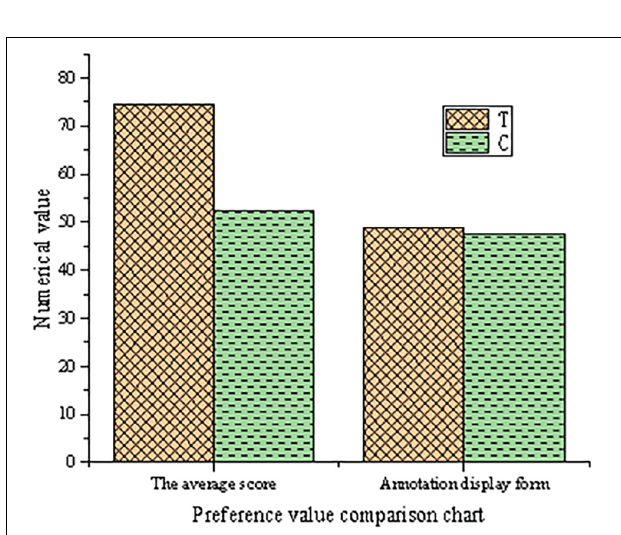
FIGURE 8 | Comparison of the preference value of users.